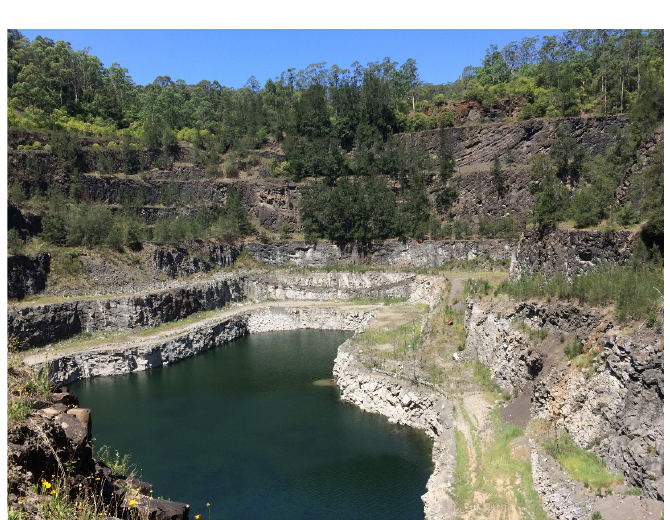
Figure 2. Dish beds in the eastern face of the Hornsby Quarry: an important feature of diatremes at the macroscale. Benches are up to 30 m in